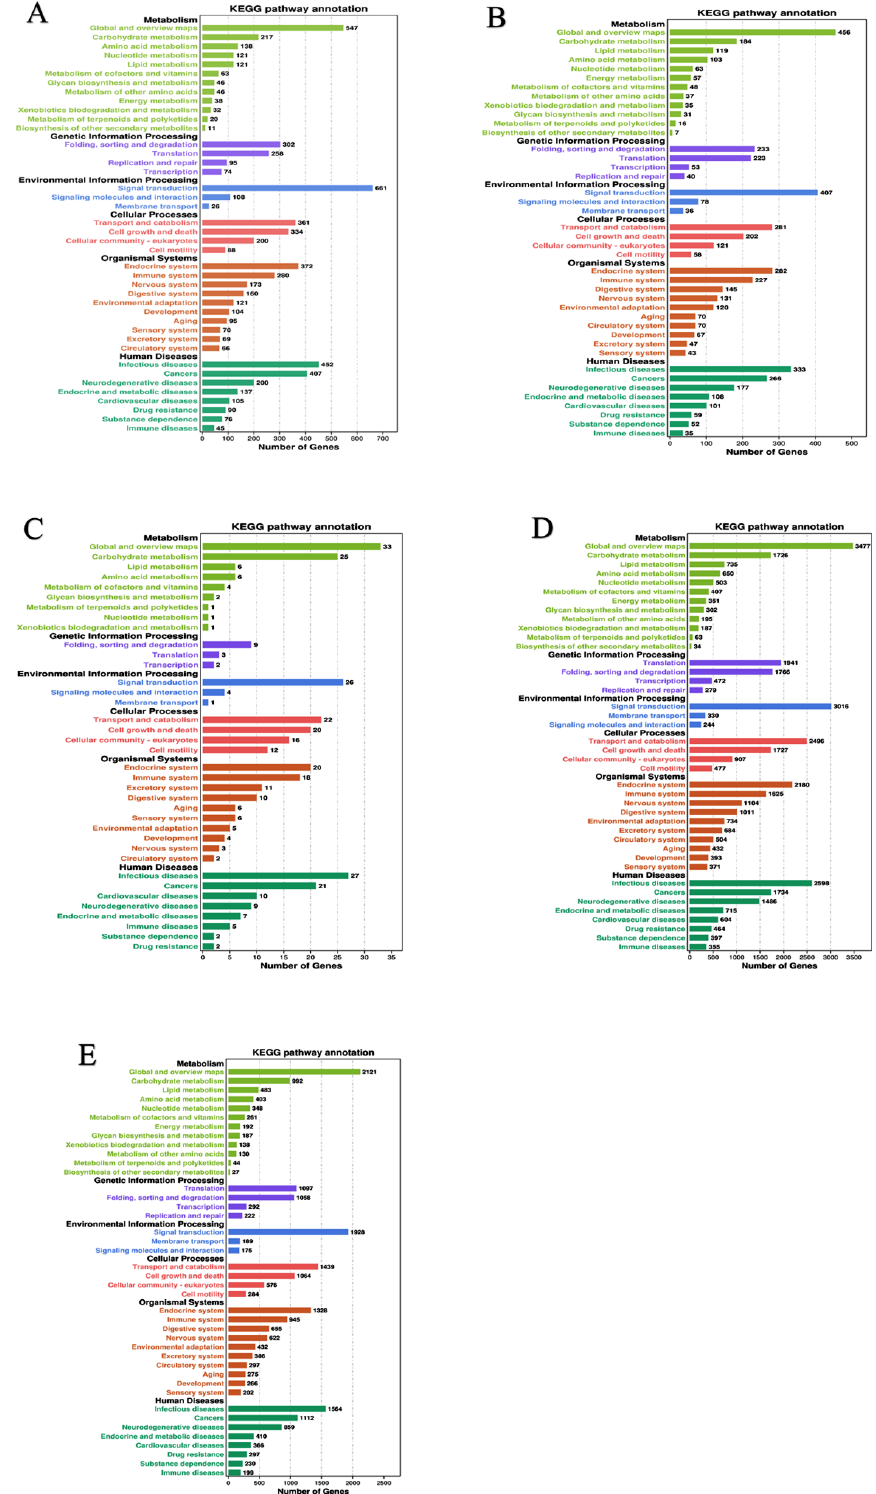
Figure 1. KEGG classifications of the R. chinensis unigenes. ( A ) PK-vs-SWRK; ( B ) PQ-vs-SWRQ; ( C ) SWRK-vs-SWRQ; ( D ) WF-vs-SWRQ; ( E ) WM-vs-SWRK. PKs (primary king), PQs (primary queen), SWRK (secondary worker reproductive king), SWRQ (secondary worker reproductive queen), WMs (workers male), and WFs (female workers), with 93,078 unigenes were assigned to 343